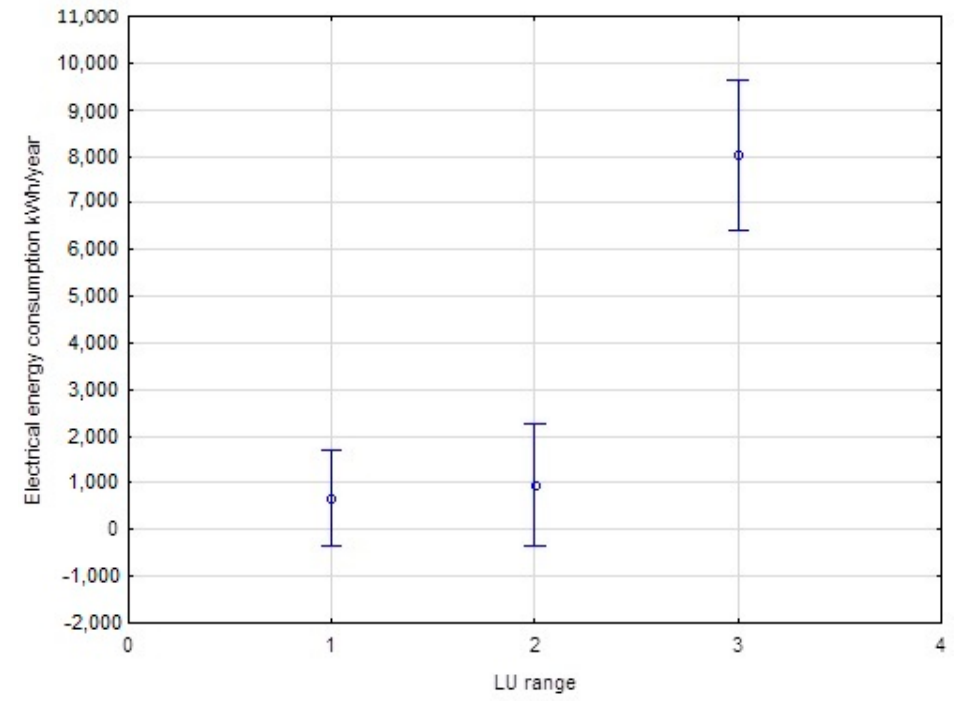
Figure 2. Dependence of electrical energy consumption on the LU number. Table 9. Average values of electrical energy consumption divided into homogeneous groups accord- ing to LU range.